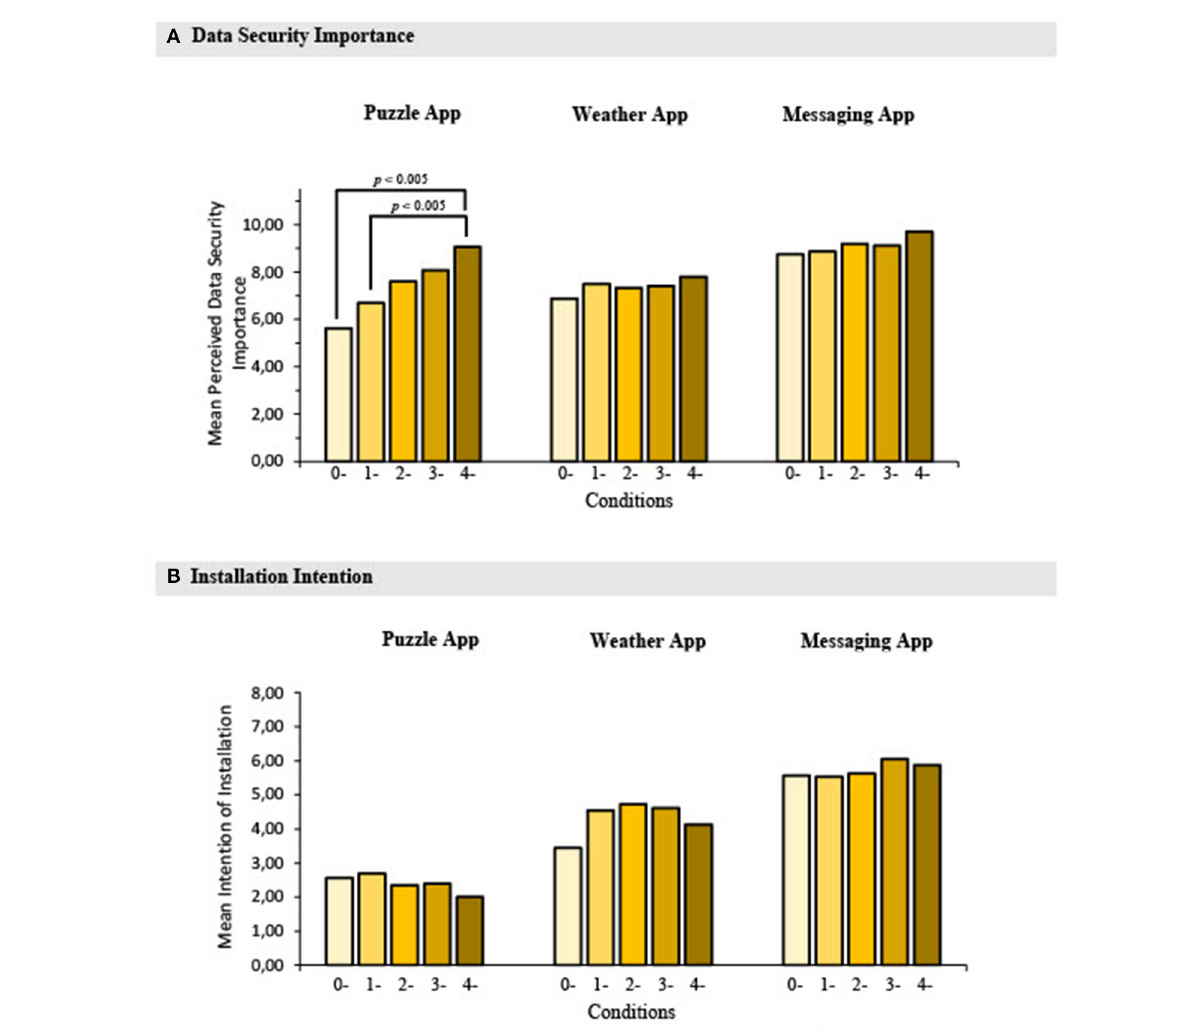
FIGURE2 Mean data security importance (A) and installation intention (B) across apps and conditions with 0-, 1-, 2-, 3-, and 4-data access permissions required, study 1. Mann-Whitney tests, using Bonferroni adjusted p -value = 0.005 for ten comparisons. Error bars with 95% confidence intervals corrected for within-subject designs were omitted from the graphs because the bars were too narrow to be